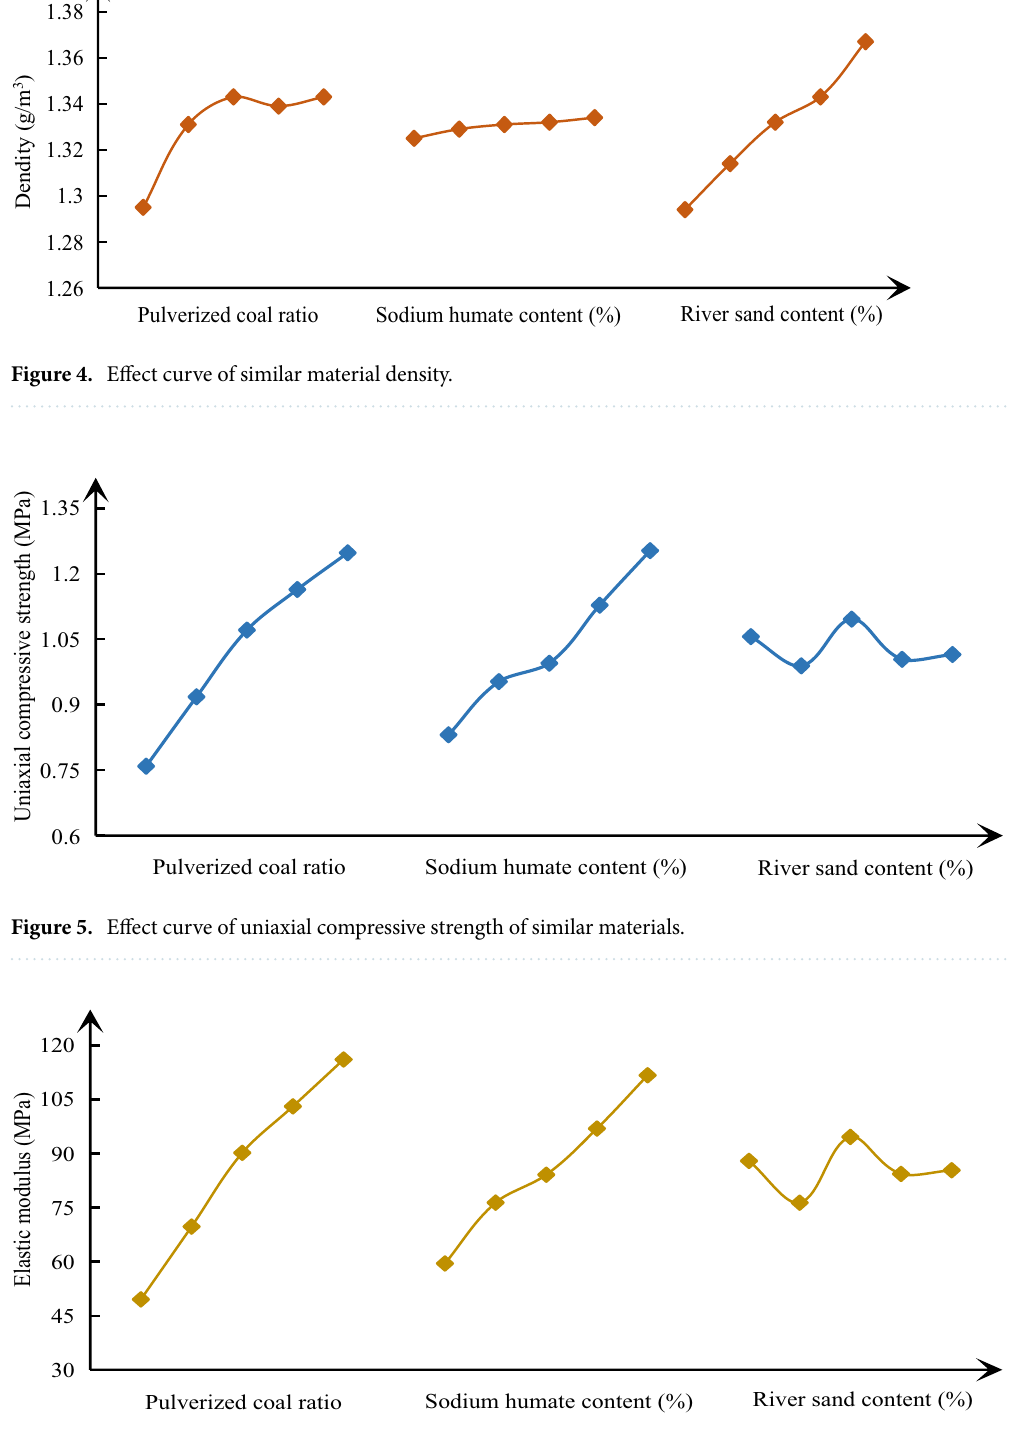
Figure 6. Effect curve of elastic modulus of similar